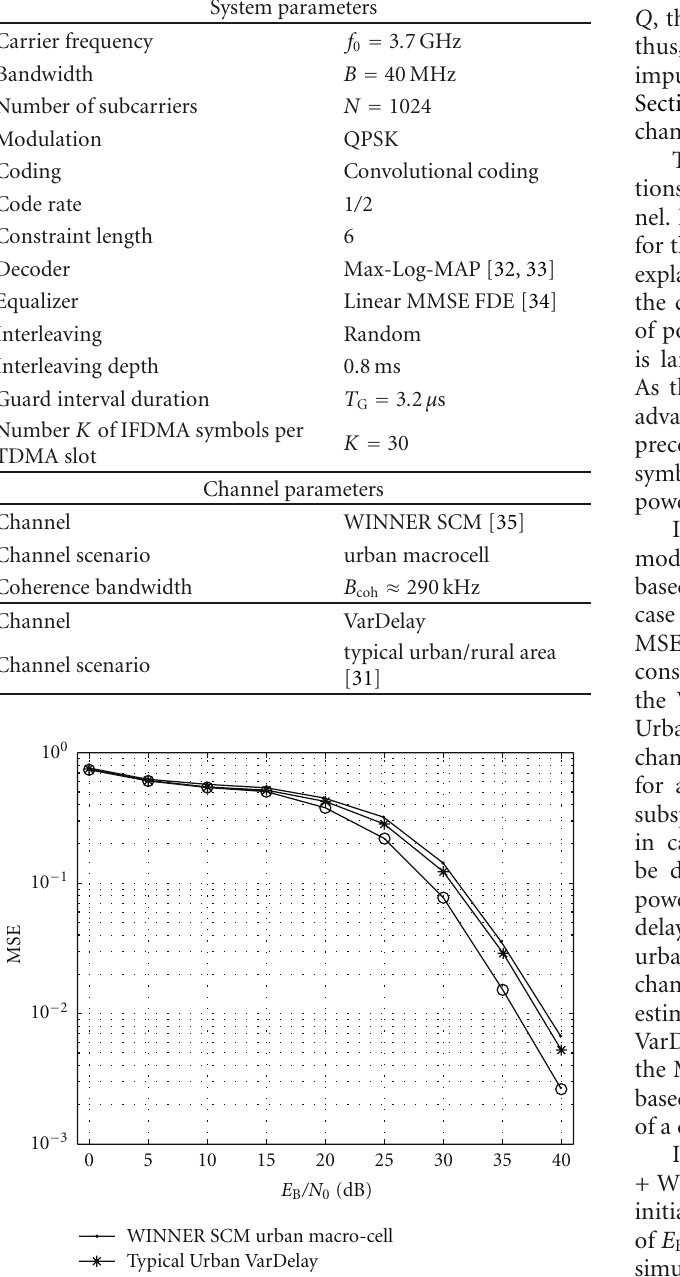
Figure 7: MSE as a function of E B /N 0 with the considered channel model as parameter assuming that Q = 8, K = 30, U = 1, v = 0km/h, and I =